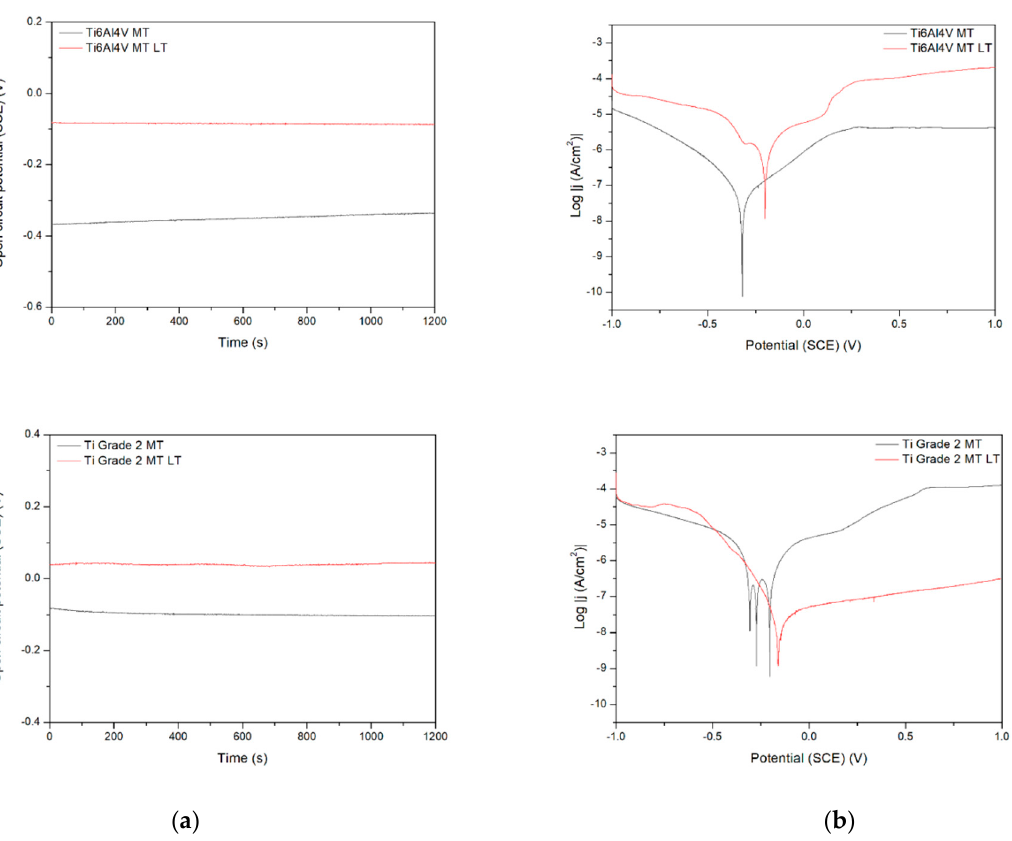
Figure 9. Open circuit potential ( a ) and potentiodynamic corrosion curves ( b ) obtained for Ti (bottom), Ti6Al4V (middle), and Ti13Nb13Zr (top), as ground (MT) and laser treated (LT) substrates.